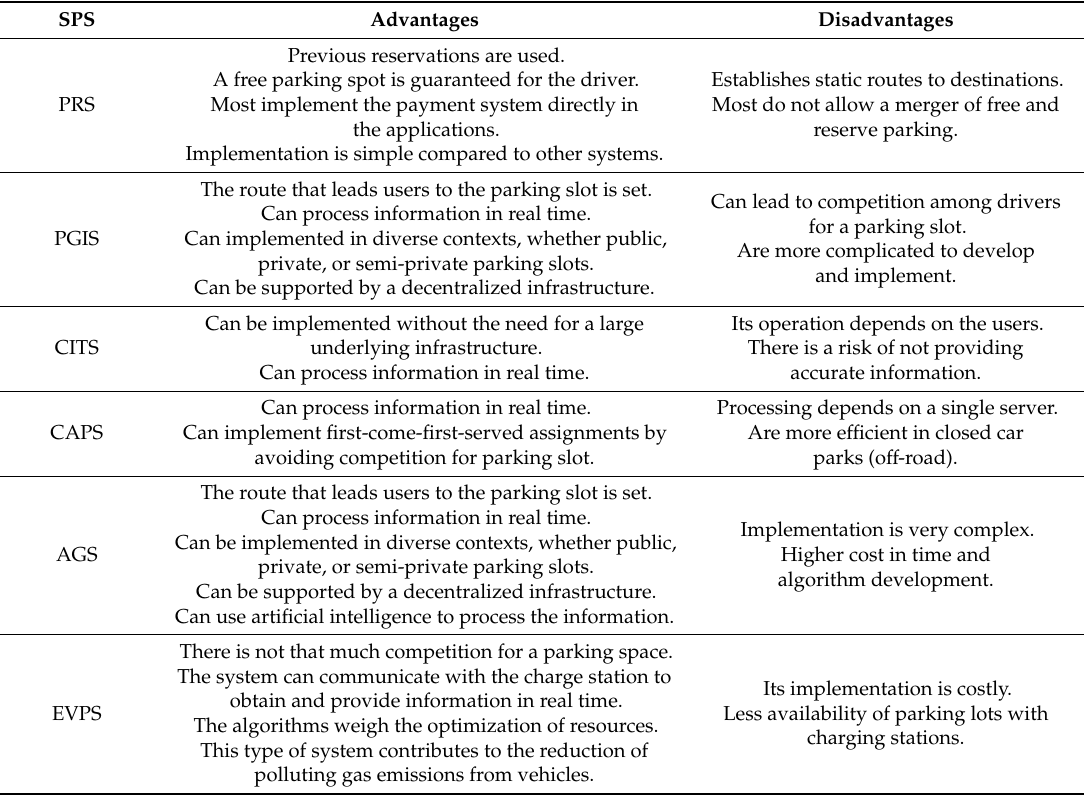
Table 6. SPS types, as well as principal advantages and disadvantages.